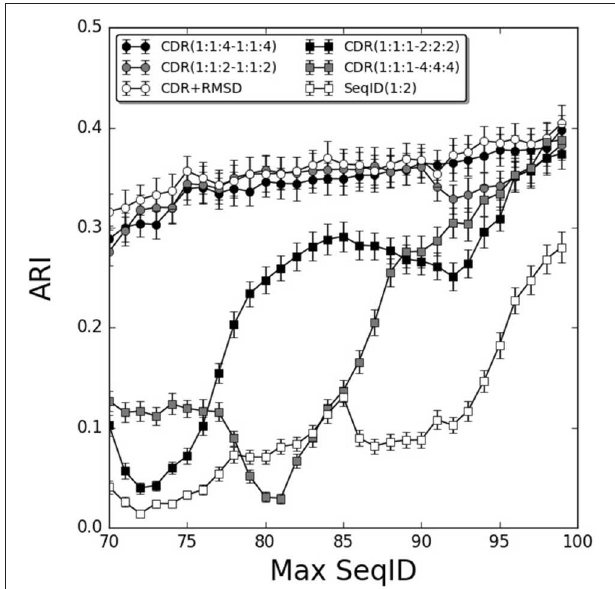
FIGURE 3 | Improving weighting schemes and adding structural similarity. Prediction performance as a function of Max SeqID using different weights for CDR loop similarities. Adding structural similarity CDR + RMSD with W = 0.9. Error bars are estimated using bootstrap with 1,000 iterations on the final prediction